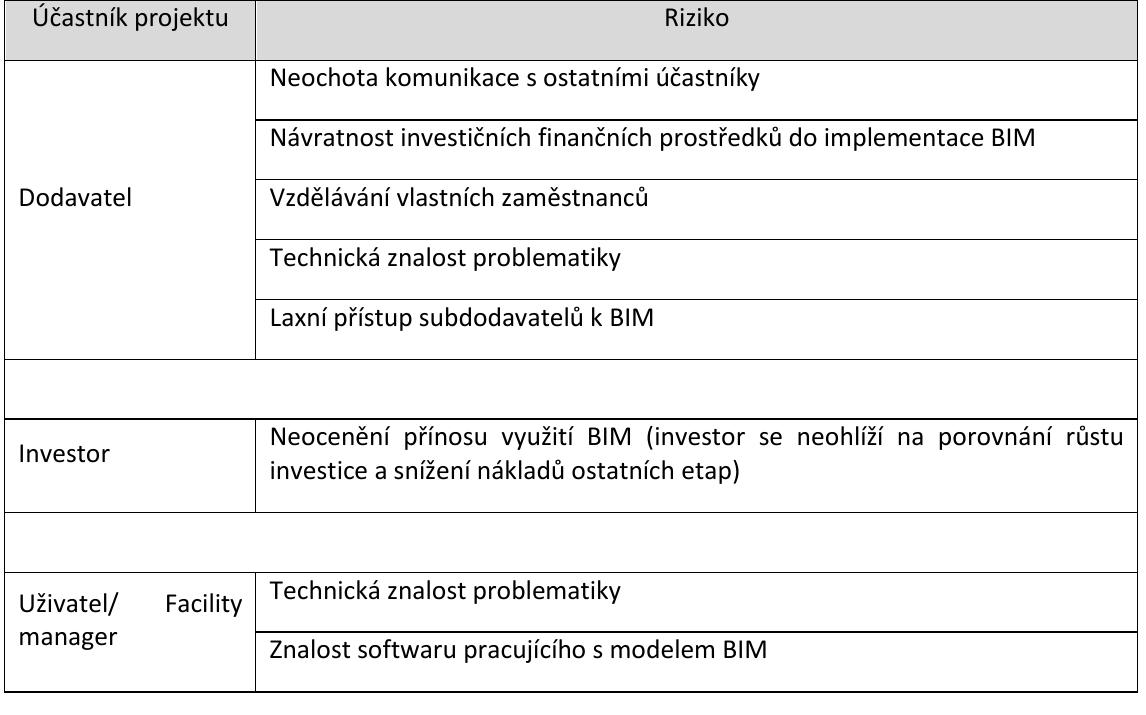
Tab. 1: Přehled rizik jednotlivých účastníků projektu ve fázi implementace BIM (zdroj: